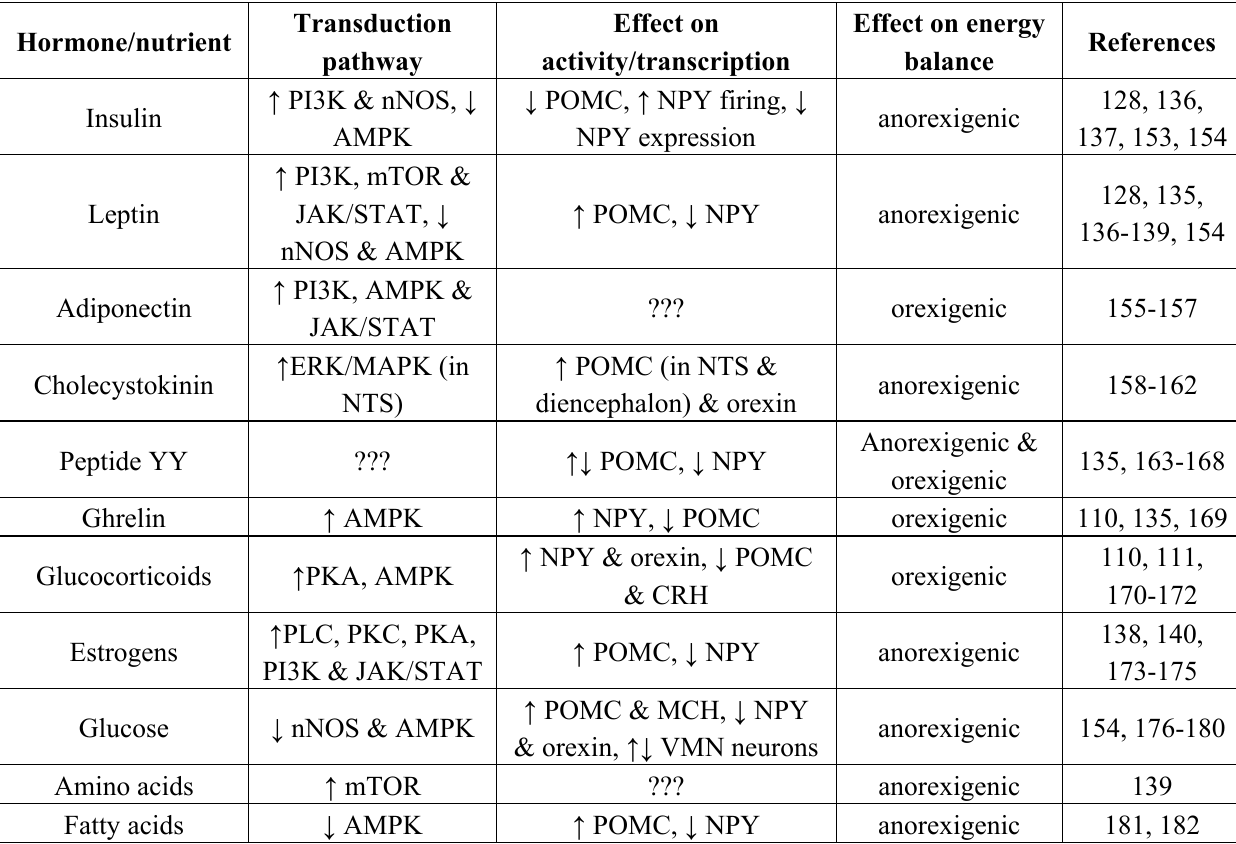
Table 2. A summary of the interrelationships between the transduction pathways modulated by hormonal and nutrient signals, and the subsequent effects on excitability, gene transcription and energy